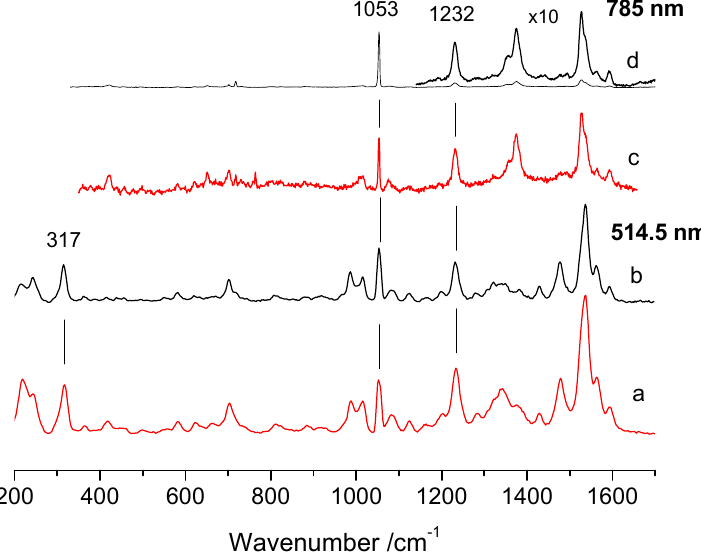
Figure 6. Representative Raman spectra of porphyrin J-aggregates in the presence ( a , c ) and absence ( b , d ) of Au 10 clusters with excitation at 514.5 and 785 nm. The spectra of each sample ( a , c ) and ( b , d ) were obtained at the same point on the sample surface for the two excitation wavelengths. The inset of spectrum ( d ) has been multiplied 10-fold. Experimental conditions: (514.5 nm): ( a ) average of twelve spectra with 10 s integration time; ( b ) average of eleven spectra with 10 s integration time; (785 nm): ( c ) average of seventeen spectra with 30 s integration time; ( d ) average of nine spectra with 30 s integration time. All the spectra have been normalized with respect to the band of nitrate at 1053 cm − 1 .